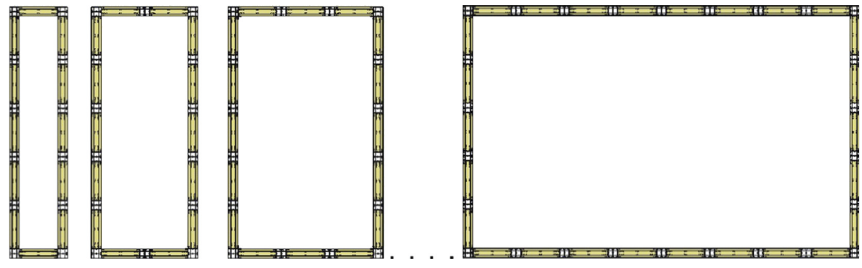
Figure 15: Series of beam frames F6M, F12M, F18M, . .. , F48M.